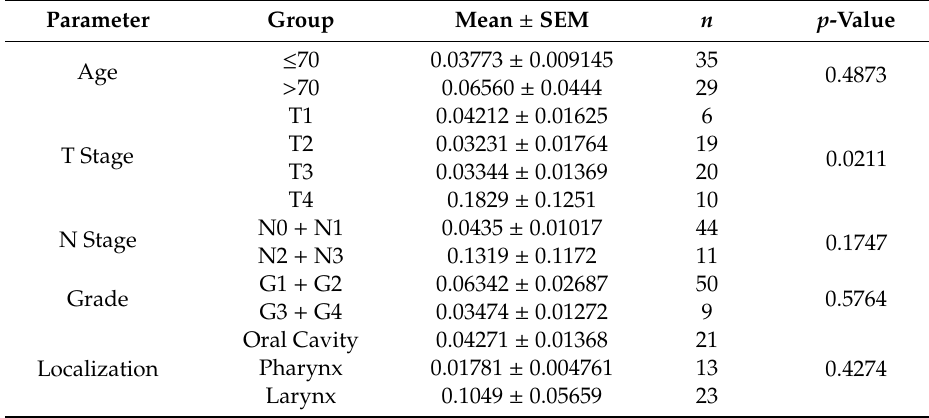
Table 1. YRNA1 expression levels in relation to clinical-pathological parameters for FFPET of head and neck squamous cell carcinoma (HNSCC) patients; T-test; Mann–Whitney test; one-way analysis of variance (ANOVA) with Dunn’s multiple comparisons post-test; p < 0.05 was considered to be significant. Varying patient numbers reflect availability of the